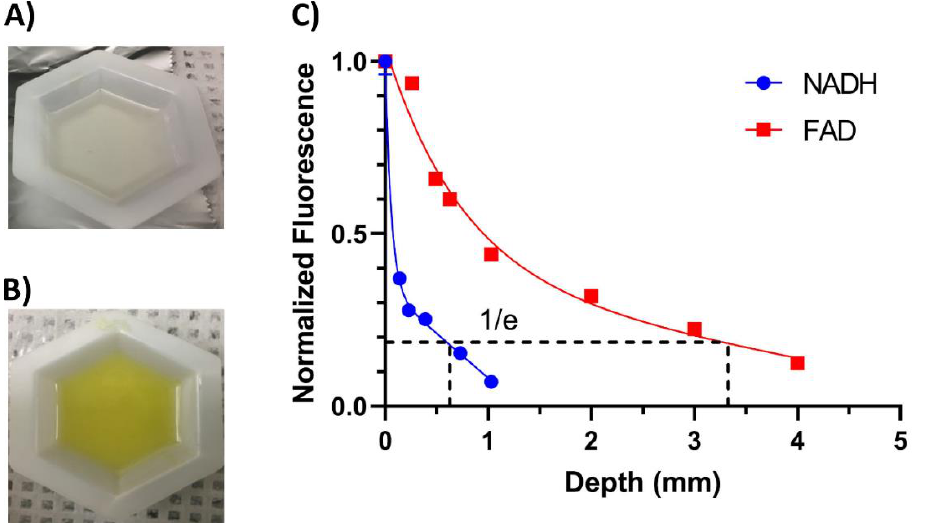
Figure 4. Depth sensitivity of the endoscopic system. Representative images of the 100 µM ( A ) NADH and ( B ) FAD resin phantoms: ( C ) Depth sensitivity of the NADH and FAD channel in liquid phantoms, with the Intralipid height when the fluorescence intensity dropping to 1/e of that measured at the resin phantom surface defined as the effective penetration depth.